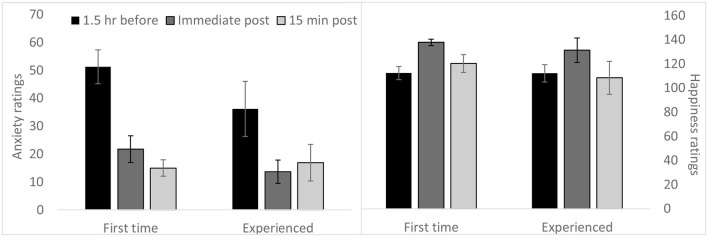
Subjective emotion ratings among first-time and experienced skydivers. Anxiety and happiness ratings among first-time and experienced jumpers at three time points across the skydiving day confirms that peak anxiety occurred at 1.5 h before the jump and happiness peaked immediately after the jump. This justifies examining these emotions specifically at those time points. Error bars indicate +/− one standard error. Range of possible values 0–160.